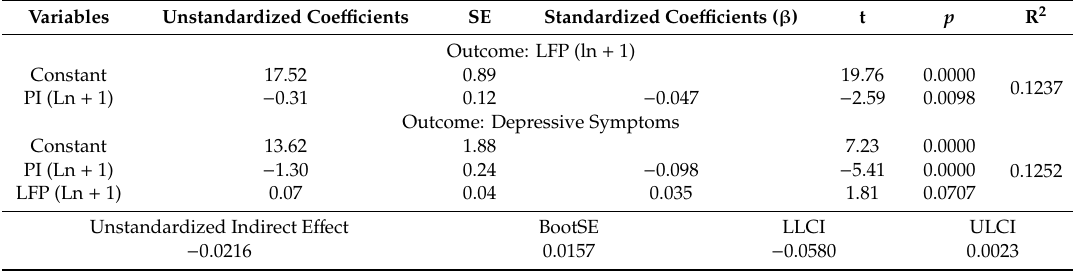
Table 2. The results of mediation